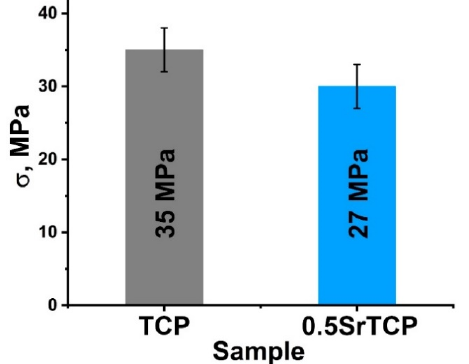
Figure 5. Mechanical strength of TCP and 0.5SrTCP ceramics sintered at 1100 °C.